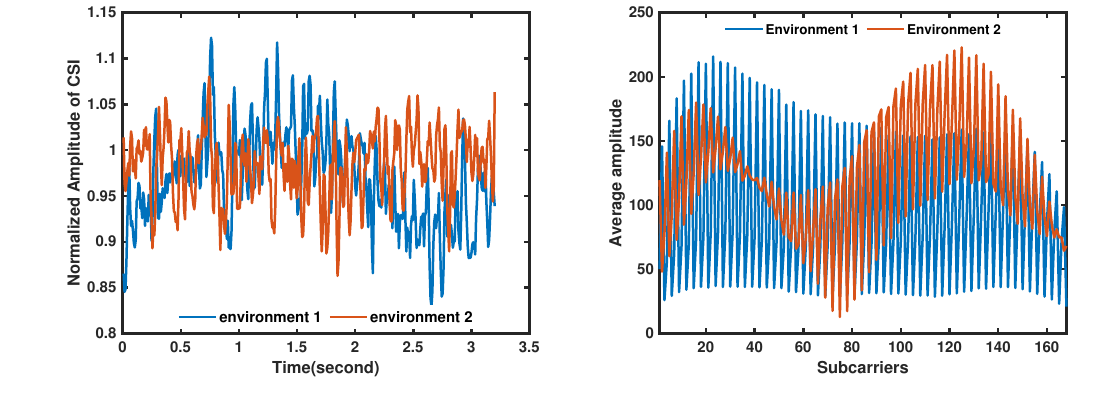
Figure 1. The influence of different environments on the